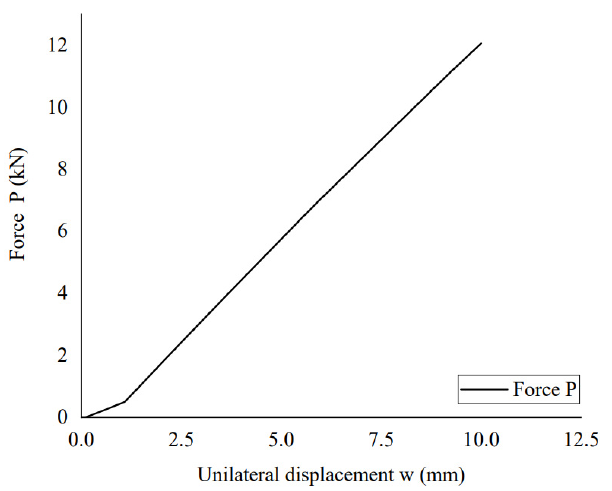
Figure 10. FE result of the hose under crush load: ( a ) displacement; ( b ) stress.